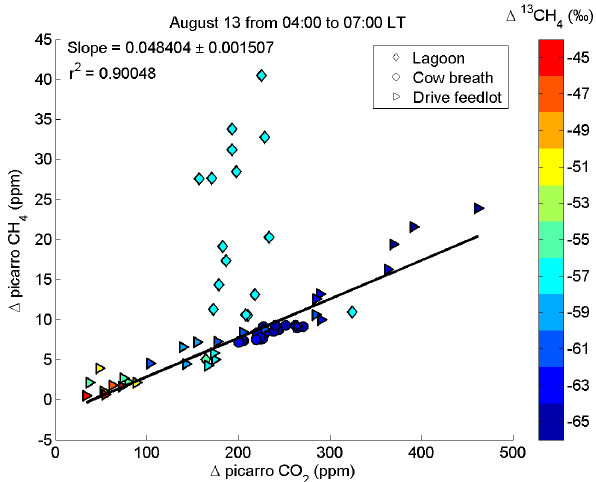
Figure 11. Scatter plot of 1min-average anomalies (from the 5min smoothed) of CH 4 vs. CO 2 , color coded using the delta CH 4 values, measured by the Picarro on 13 August from 04:00 to